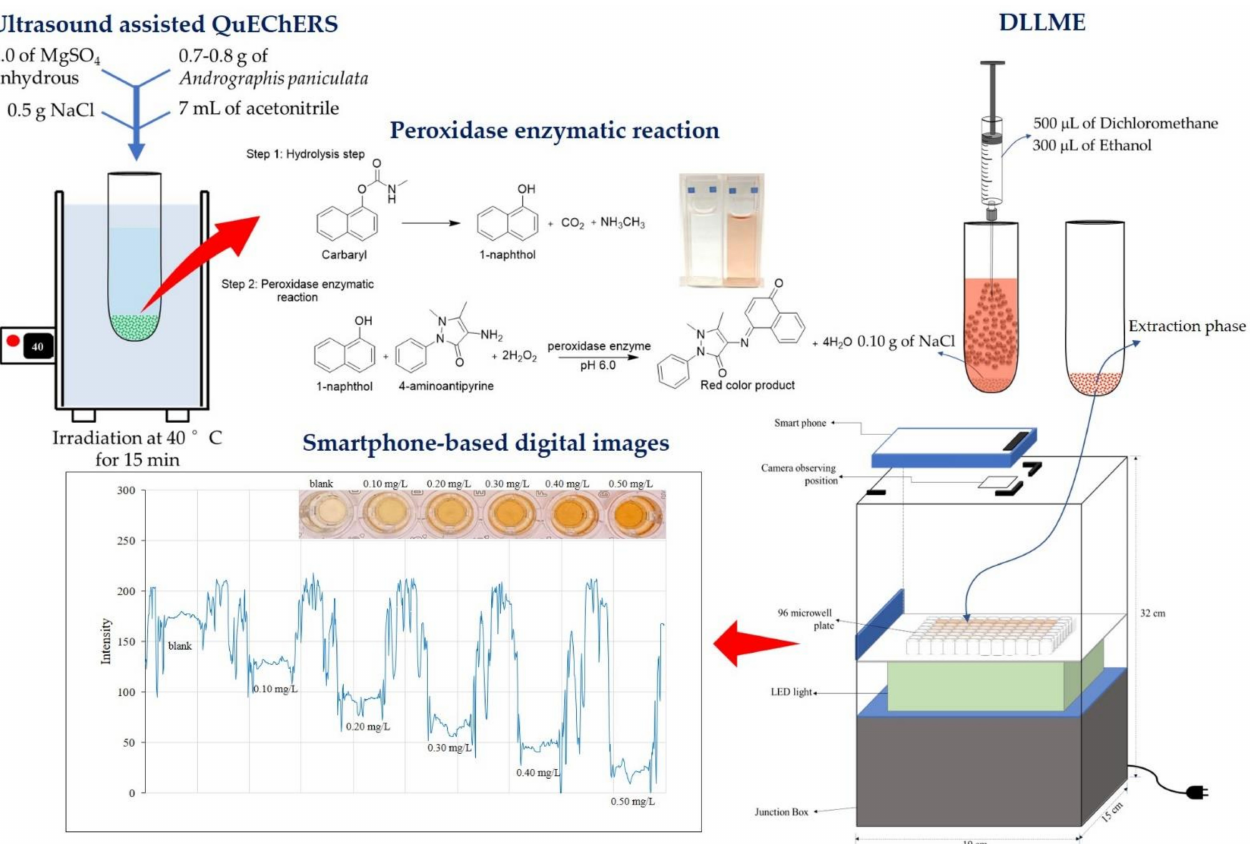
Figure 5. Illustration of DLLME synergy with smartphone-based digital images for the determi- nation of carbaryl using enzymatic reaction of crude peroxidase enzyme extracts from cassia bark as